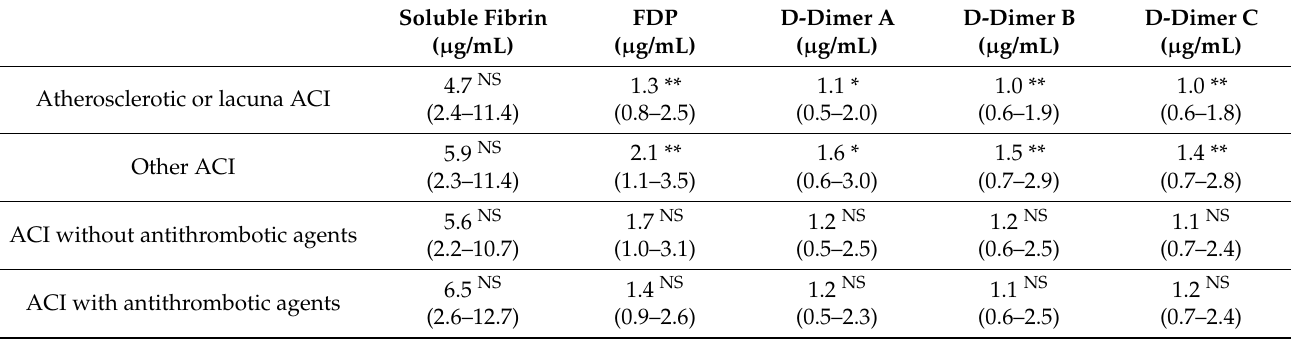
Table 3. Plasma levels of FDP, D-dimer, and soluble fibrin between patients with atherosclerotic or lacuna ACI and other ACI and between ACI patients treated with and without antithrombotic